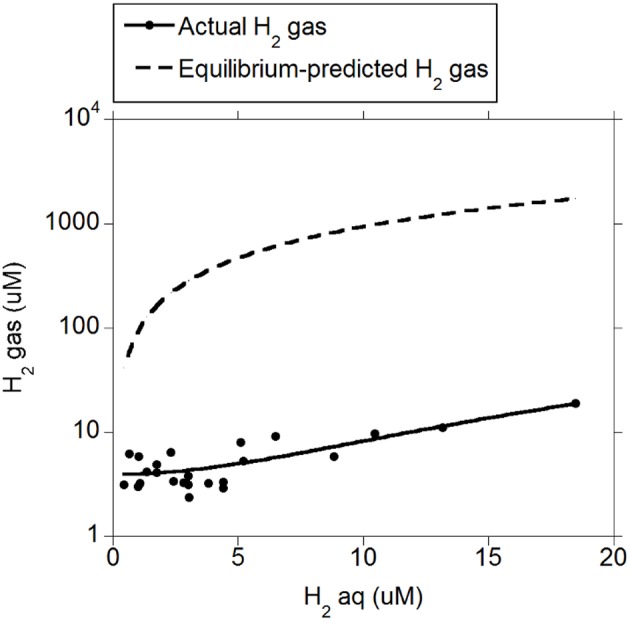
Relationship between measured and equilibrium-predicted gaseous H2 and dissolved H2 concentration: H2 (g) = 3.83 (±0.43; P < 0.001) ± 1.20 (±0.28; P < 0.001) diet + 0.18 (±0.11; P = 0.11) (H2(aq)) + 0.052 (±0.011; P < 0.001) (H2 (aq) − 4.42)2; R2 = 0.91 (P < 0.001); Equilibrium-predicted H2 (g): H2 (aq)/(α × Pt), where α is the Bunsen coefficient and Pt is the atmospheric pressure.